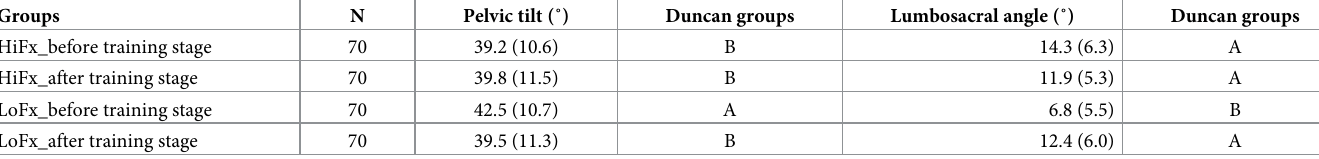
Table 6. Pelvic tilt and lumbosacral angle of Duncan groups for varying flexibility and training combinations. Groups